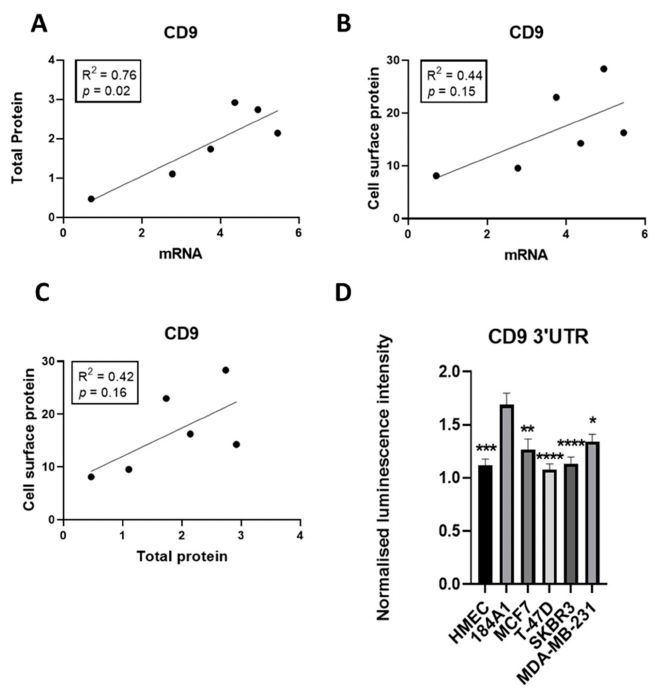
Figure 4. CD9 mRNA and total protein expression levels positively correlate and there is di ff erential CD9 3 (cid:48) UTR activity in breast cancer cell lines. ( A ). Linear regression analysis of CD9 mRNA and total protein expression levels across the breast cell line panel. ( B ). Correlation between CD9 mRNA and CD9 cell surface protein levels as measured using linear regression analysis. ( C ). Linear regression analysis of CD9 total protein and CD9 cell surface protein expression levels. ( D ). Endogenous activity of the CD9 3 (cid:48) UTR was measured using a CD9 3 (cid:48) UTR dual luciferase reporter assay in non-tumorigenic and tumorigenic breast cell lines. n = 3; * p = 0.02, ** p = 0.002, *** p = 0.0001, **** p <